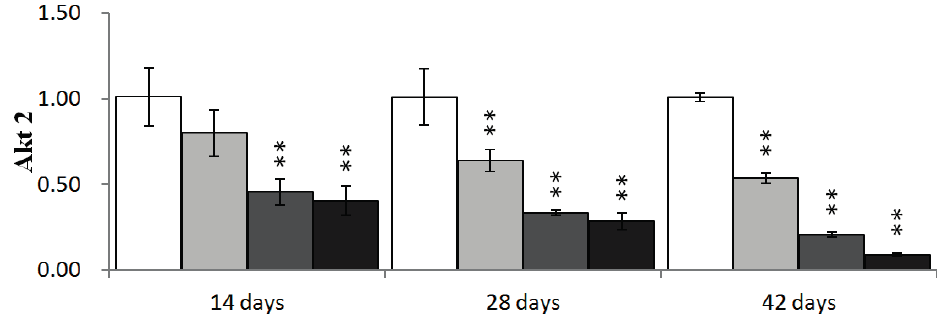
Figure 9. The mRNA expression levels of PI3K, Akt1 and Akt2 in the kidney. Data are presented with the mean ± standard deviation ( n = 5); * p < 0.05, compared with the control group; ** p < 0.01, compared with the control